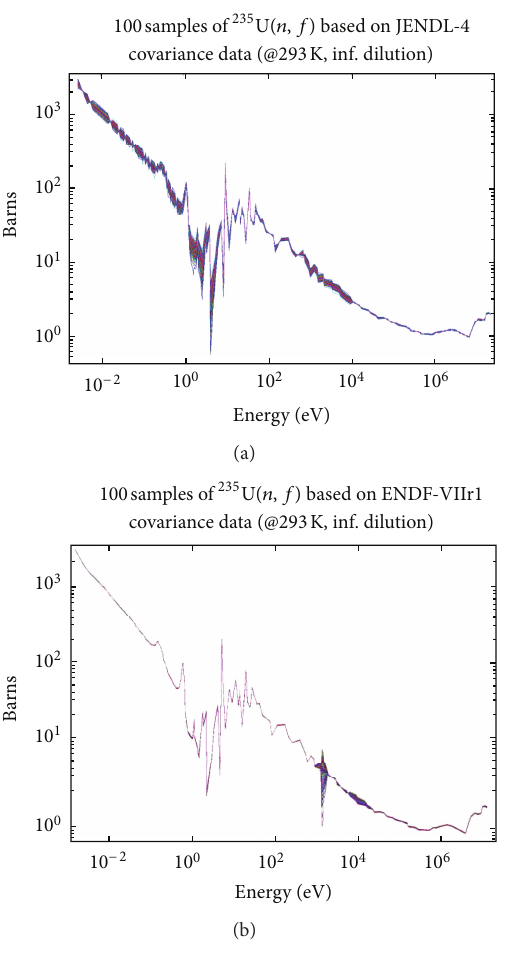
F 16: 100 LHS samples taken from the cross- section and based on the different JENDL-4 and ENDF/B-VII.1 covariance